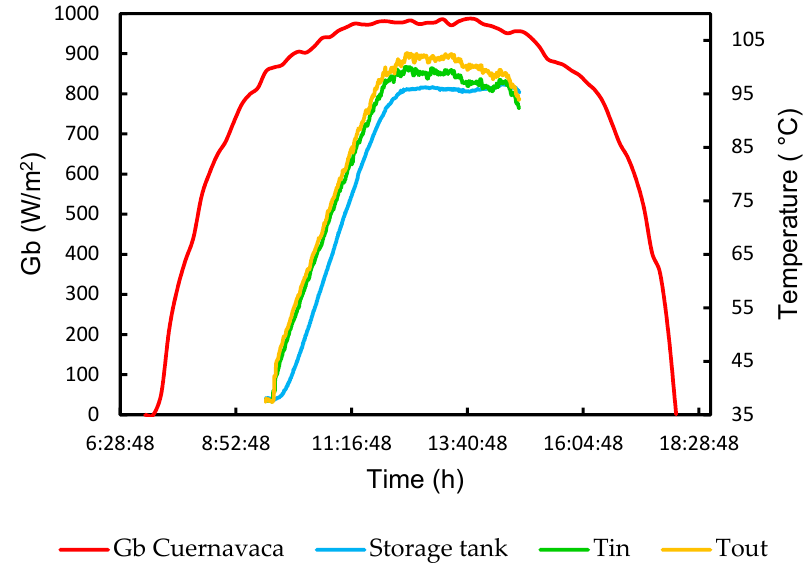
Figure 10. Behavior G b and outlet, inlet and storage tank temperatures, 11 December 2017.